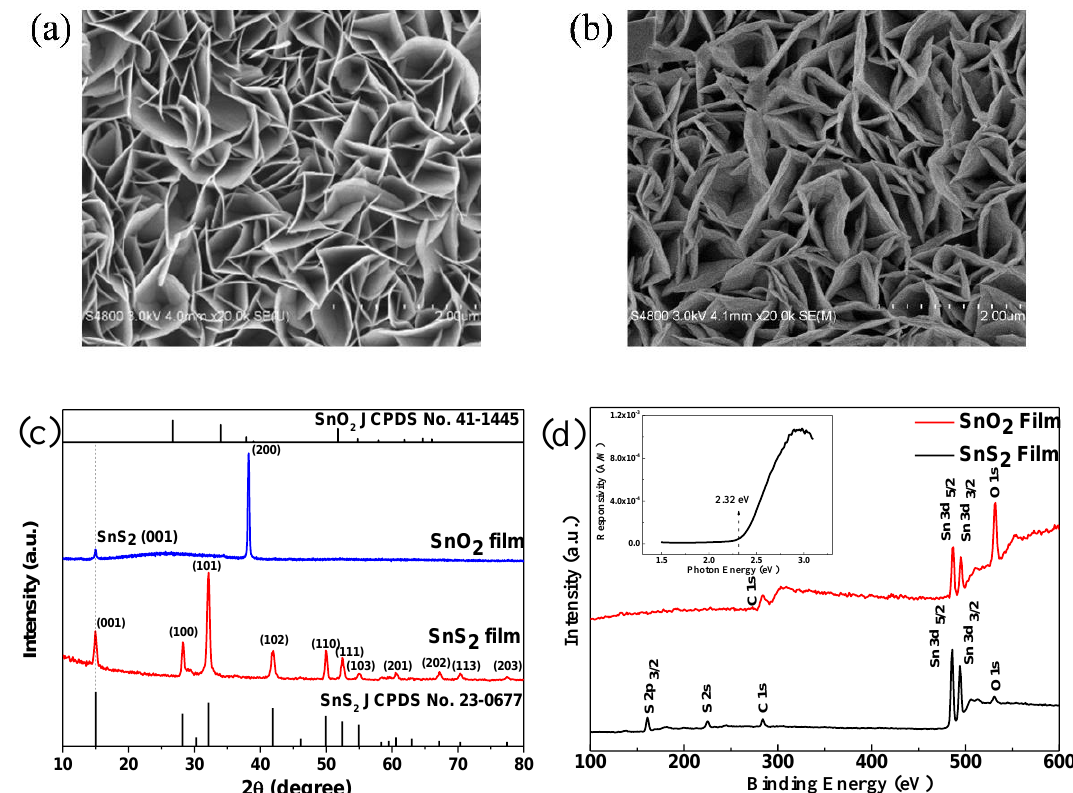
Figure 1. (Color online) ( a ) SEM image of SnS 2 film and ( b ) SnO 2 film oxidized by hydrogen peroxide (H 2 O 2 ); ( c ) X-ray diffraction (XRD) patterns of SnS 2 (red) and SnO 2 (blue) films and SnS 2 and SnO 2 of the JCPDS database (black); ( d ) XPS spectra of SnS 2 (black) and SnO 2 (brown) films. The inset is the photoconductivity measurement of SnS 2 film with band gap of 2.32 eV indicated by the dashed line.